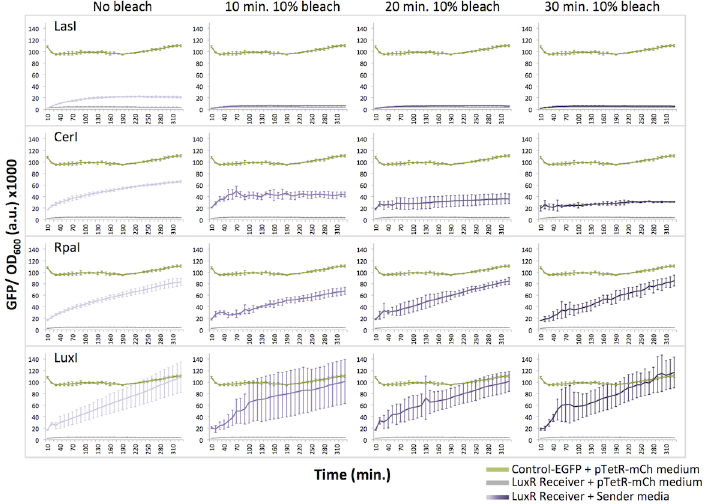
Fig 6. Bleach is not sufficient to deactivate media containing homoserine lactones (HSLs). Induction of the LuxR receiver device with untreated or treated media from LasI, CerI, RpaI, and LuxI Sender cultures. Treated cultures were incubated for 10 min, 20 min or 30 min at a final concentration of 10%